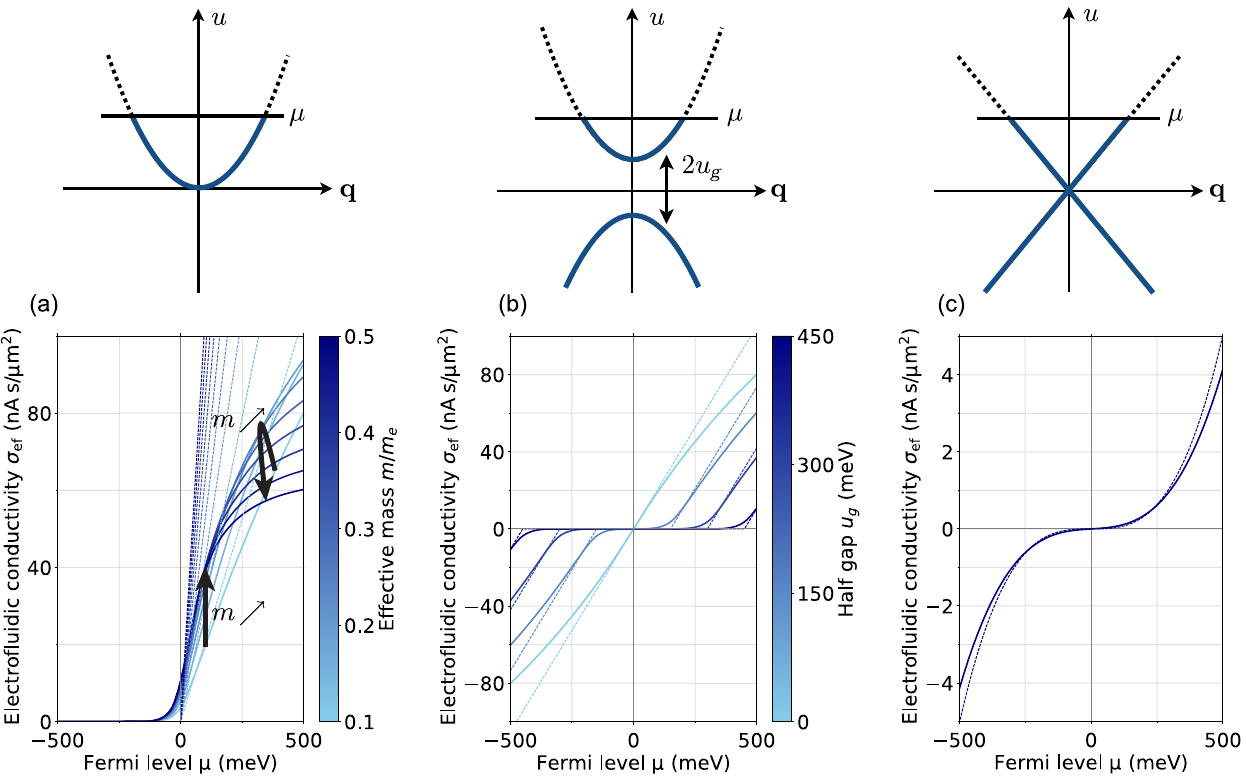
¼ h j i = v l as computed with Eq. (36), for different models of the solid el , and band gap 2 u . (c) Graphene, with constant Fermi velocity in the Dirac g e Þ ¼ 10 6 . The dashed lines correspond to the prediction of Eq. (49), with no chemical um